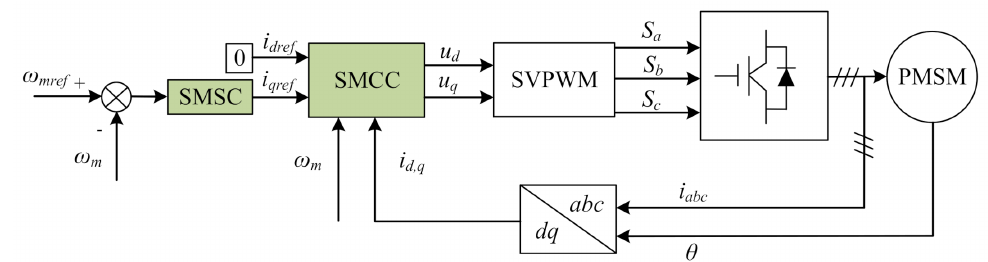
Figure 2. Block diagram of the FOC system with the SMSC and SMCC of the PMSM.